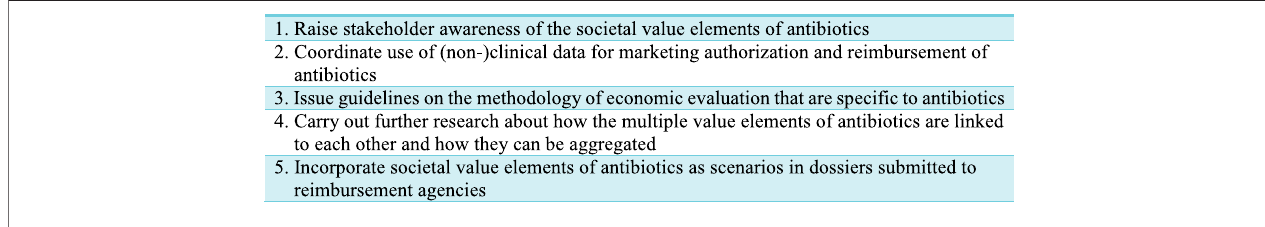
FIGURE 2 | Recommendations to improve antibiotic